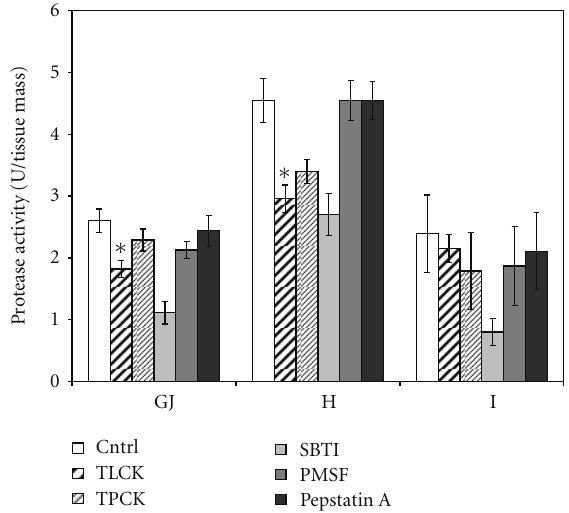
Figure 5: E ff ect of specific inhibitors on alkaline protease activity in the gastric juice (GJ), hepatopancreas (H), and intestine (I) of Cherax albidus . The percentage of inhibition was calculated considering the total activity (without inhibitor). Data represent means ± SEM. For each group, n = 10. Asterisks represent statistically significantdi ff erences ( P < . 05)along the digestive tract. ( F (2.27) = 3.98 for TLCK